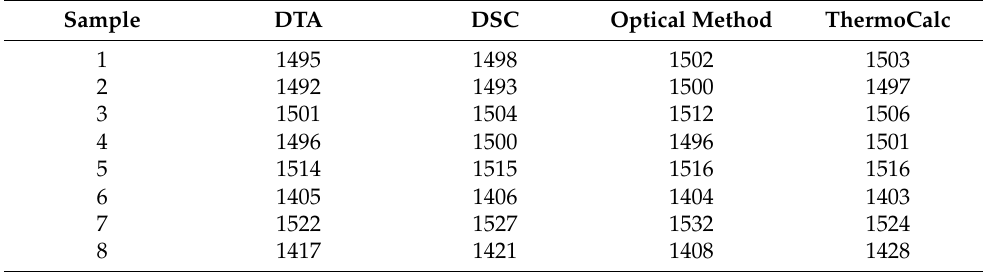
Table 2. Measured and calculated liquidus temperatures ( ◦